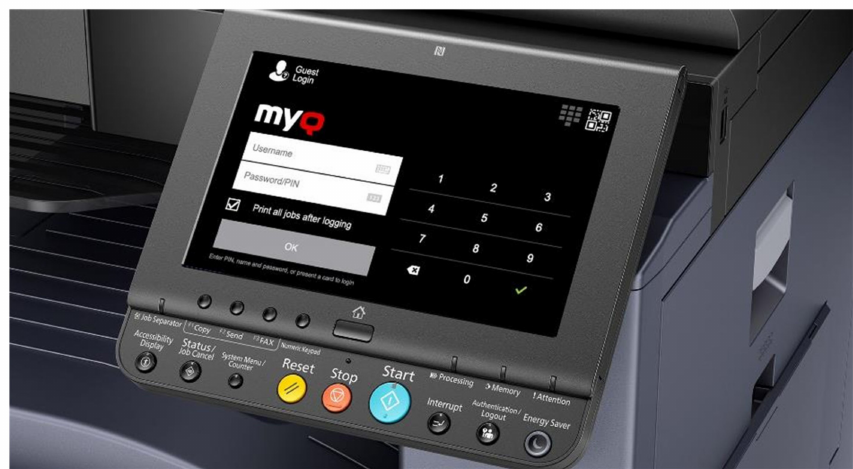
Figure 7. Visualization of the splash screen on printers with the new system. Source: Janus Ltd.,